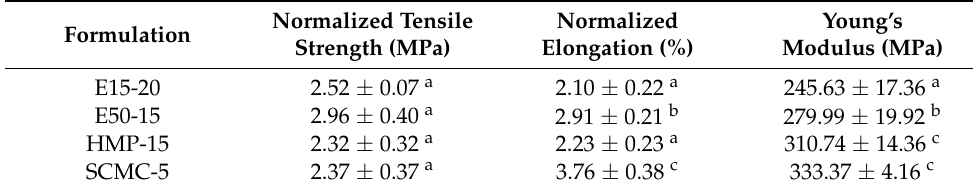
Table 5. Mechanical characteristics of 3D-printed ODFs.